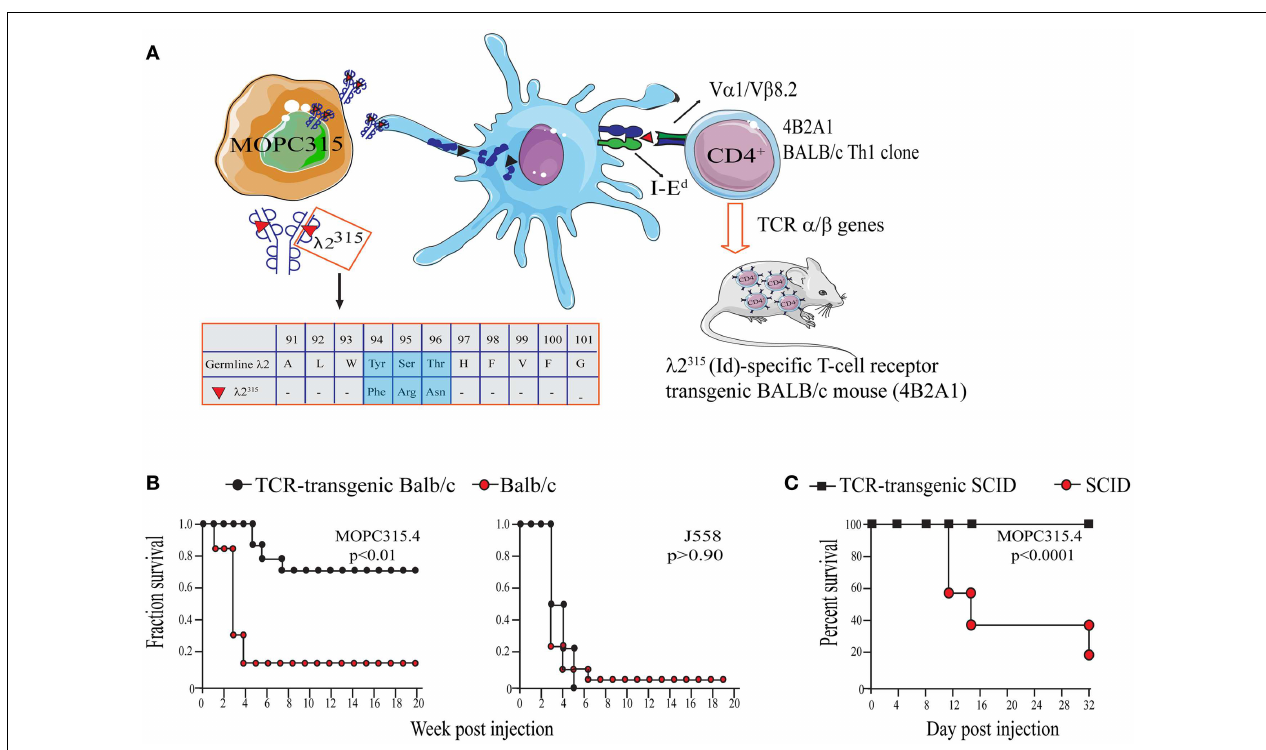
FIGURE 2 |The MOPC315 myeloma model. Naïve tumor-specific CD4 + T cells protect against MHC II NEG tumor challenge in the absence of otherT cells and B cells. (A) MOPC315 myeloma cells of BALB/c origin secrete an IgA M315 myeloma protein with a mutated λ 2 light chain referred to as λ 2 315 . M315 is endocytosed and processed by BALB/c APCs, and a CDR3 sequence that includes residues 91–101 of λ 2 315 is presented on the